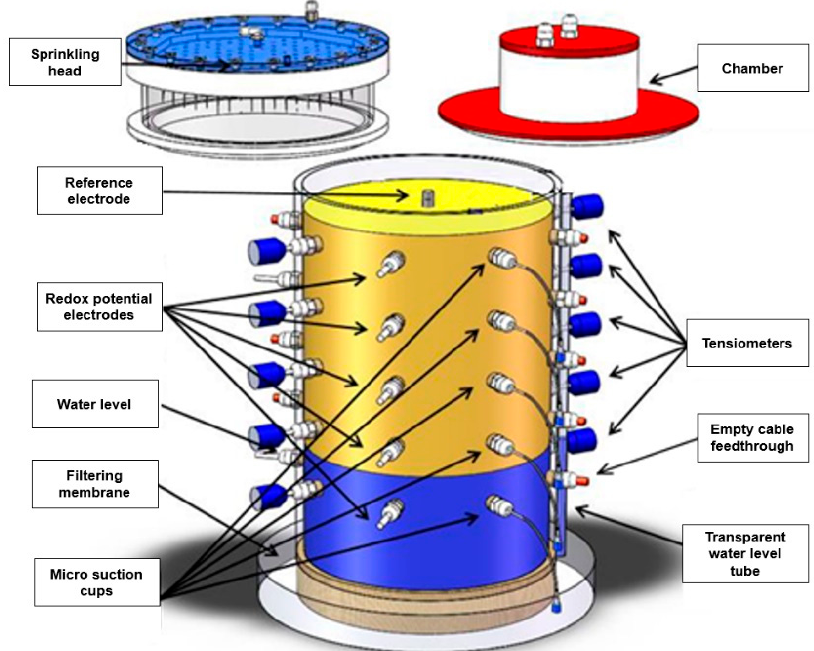
Figure 1. Schematic diagram of the lysimeter system (internal diameter: 30 cm, height: 50 cm). A sprinkling system was used to simulate precipitation or fertilization process in the lysimeter, and the closed chamber method was used to measure the fluxes of greenhouse gases (PT100 sensors are not shown).